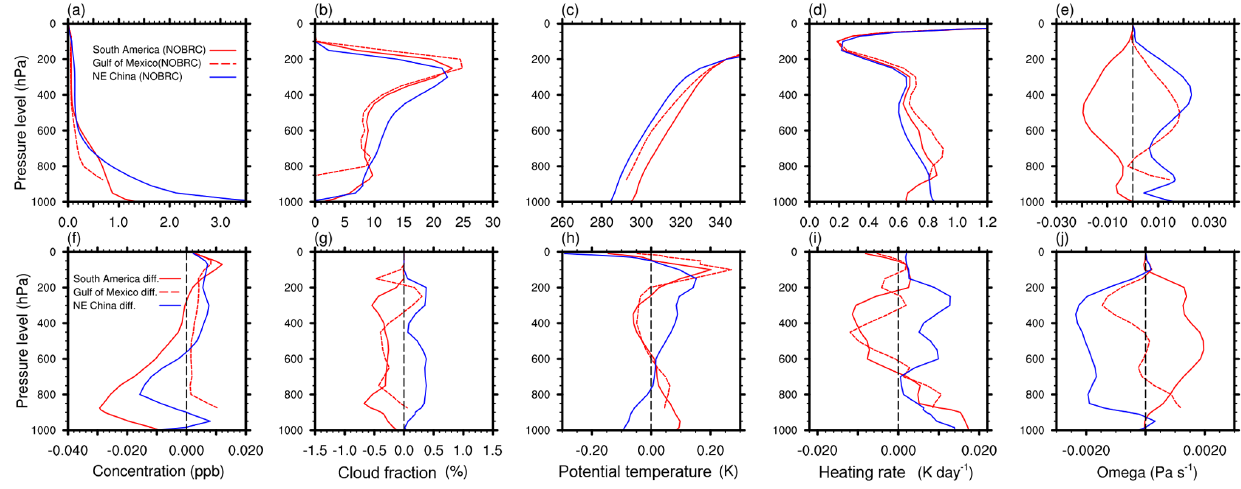
Figure 11. Vertical profiles (a–e) and vertical profile perturbations (f–j) for the sites in South America (SA), the Gulf of Mexico (GM), and northeastern China (NEC). In (a) – (e) the model run NOBRC is plotted, and the difference between BRC and NOBRC is plotted in (f) – (j) . Red represents regions with a positive REari and blue represents regions with a negative